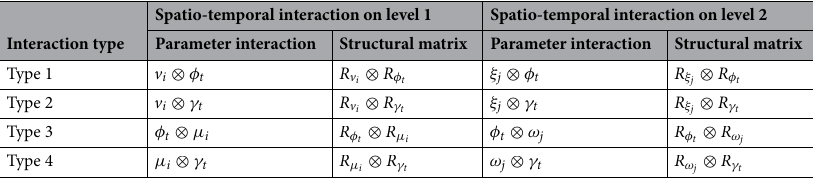
Table 4. Four types of spatio-temporal interaction.